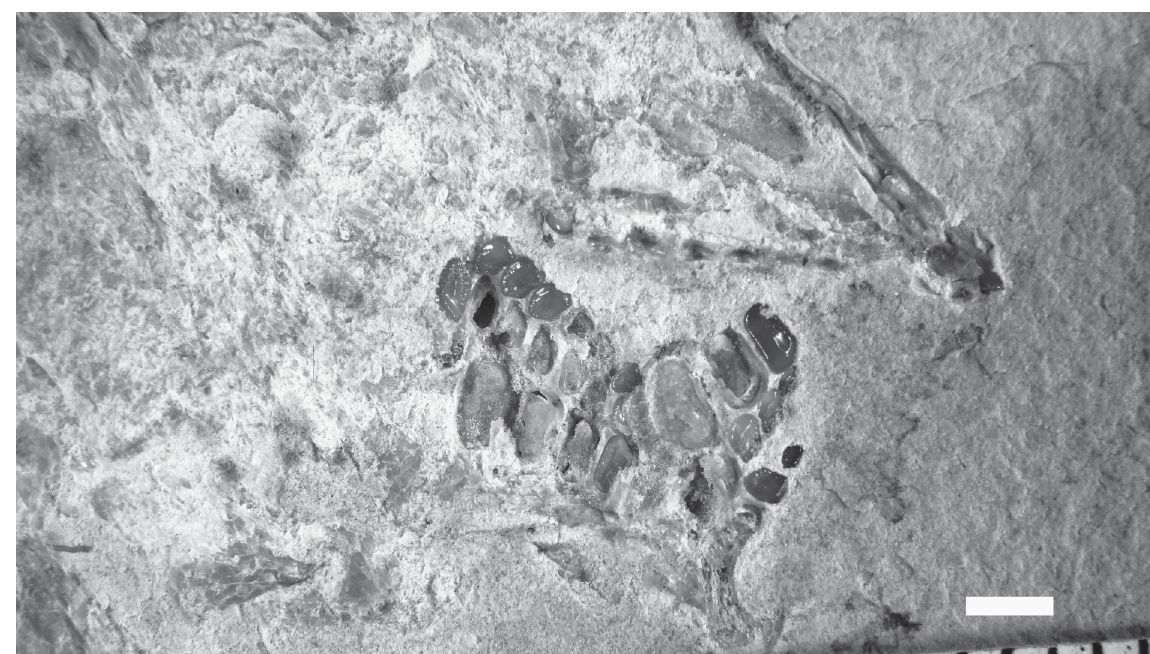
Fig. 5. Libanopycnodus wenzi gen. et sp. nov., holotype, snout, prearticulars and hyoid bar (CLC S-574). Scale bar: 2 mm